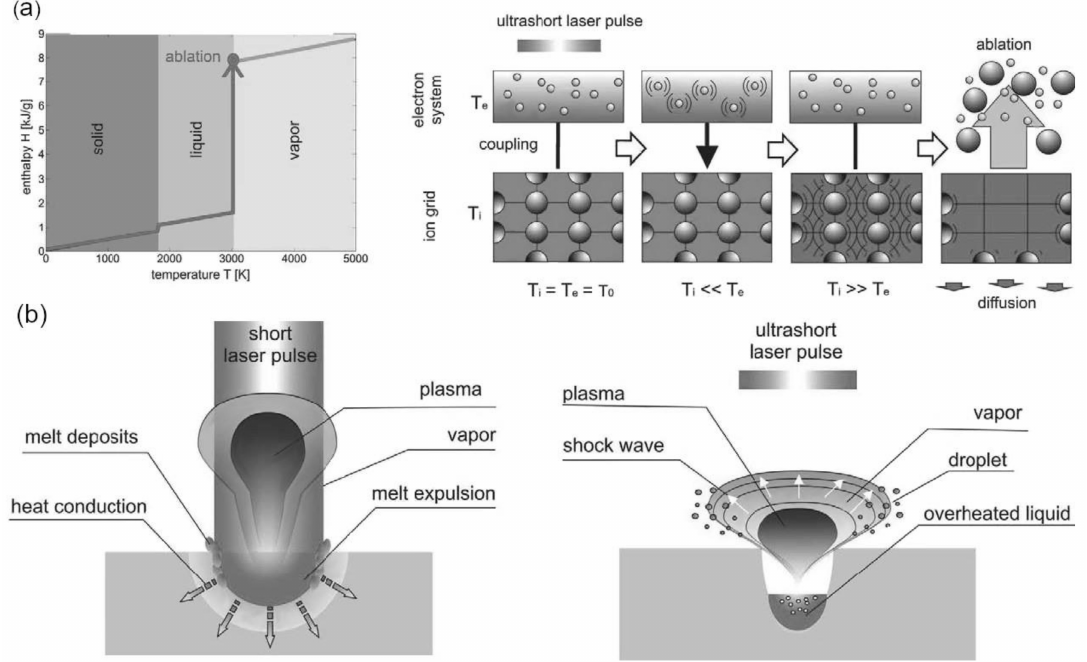
Figure 1. Ablation models: ( a ) classical ablation model; ( b ) two-temperature model as basis of ultrafast ablation model. Beam-Matter interaction: ( c ) classical beam-matter interaction; ( d ) ultrafast beam-matter interaction (Reprinted with permission from